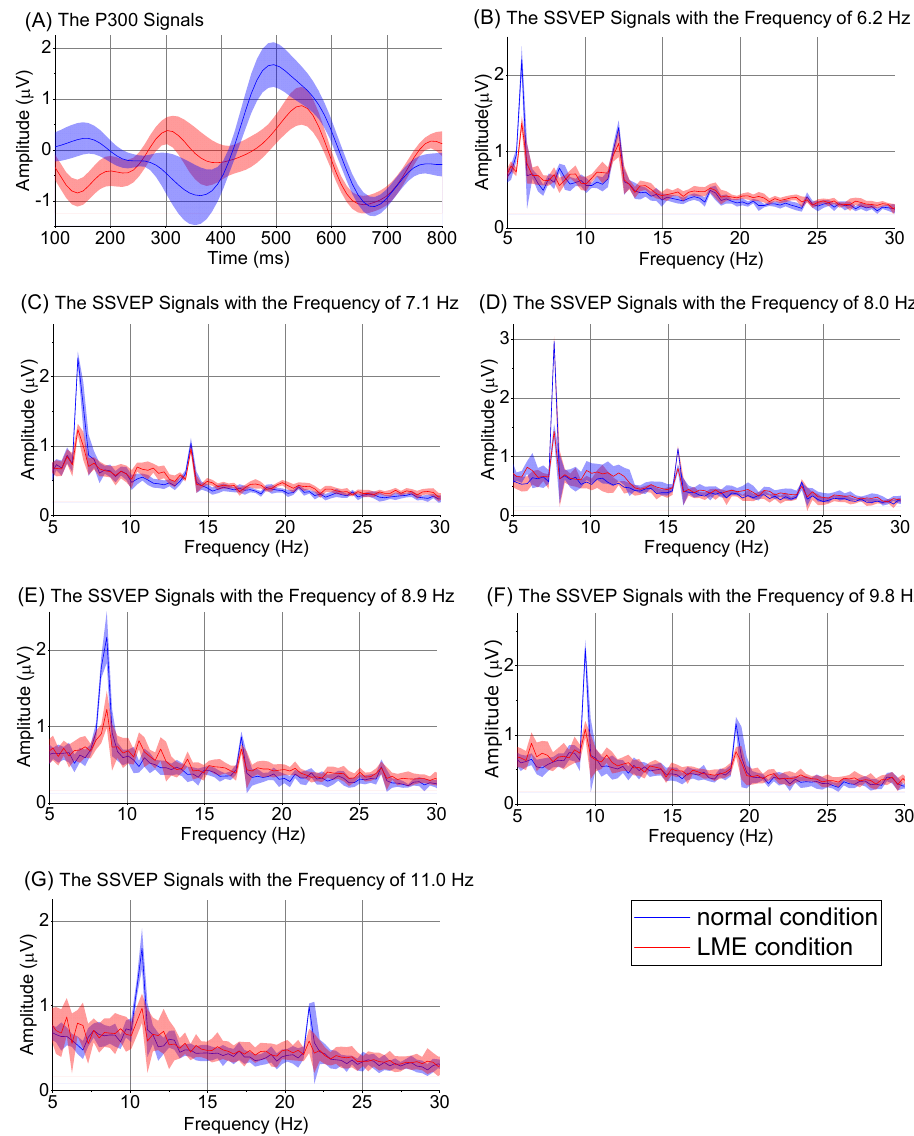
Figure 5. Evoked P300 signals and SSVEP signals. Table 1. Accuracy and ITR with the P300-based